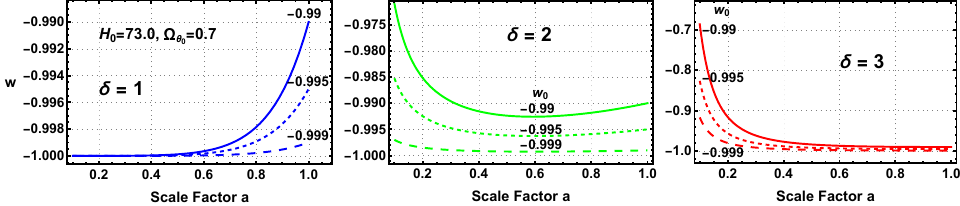
Figure 12. The evolution of the dark energy equation of state for all of the cases in this study. The δ = 1 w evolution is the classic thawing evolution, where w is initially near −